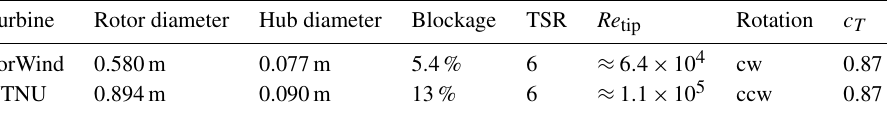
Table 1. Summary of main turbine characteristics. The tip speed ratio (TSR) is based on the free-stream velocity u ref at hub height. The Reynolds number at the blade tip, Re tip , is based on the chord length at the blade tip and the effective velocity during turbine operation. For the ForWind turbine, 0.96 R was chosen as the radial position to account for the rounded blade tips. The blockage corresponds to the ratio of the rotor’s swept area to the wind tunnel’s cross-sectional area. The direction of rotation refers to observing the rotor from upstream, with (c)cw meaning (counter)clockwise. The thrust coefficients were measured at γ = 0 ◦ and corrected for thrust on the tower and support structure.